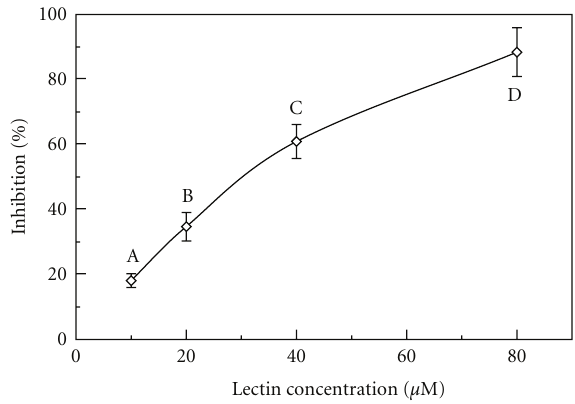
Figure 4: Inhibitory e ff ect of HEA on activity of HIV-1 reverse transcriptase. Results represent mean ± SD ( n = 3). The IC 50 value is 31.7 μ M. Di ff erent alphabets next to the data points indicate statistically significant di ff erence ( P < . 05) when the data are analyzed by analysis of variance followed by Duncan’s multiple range test.